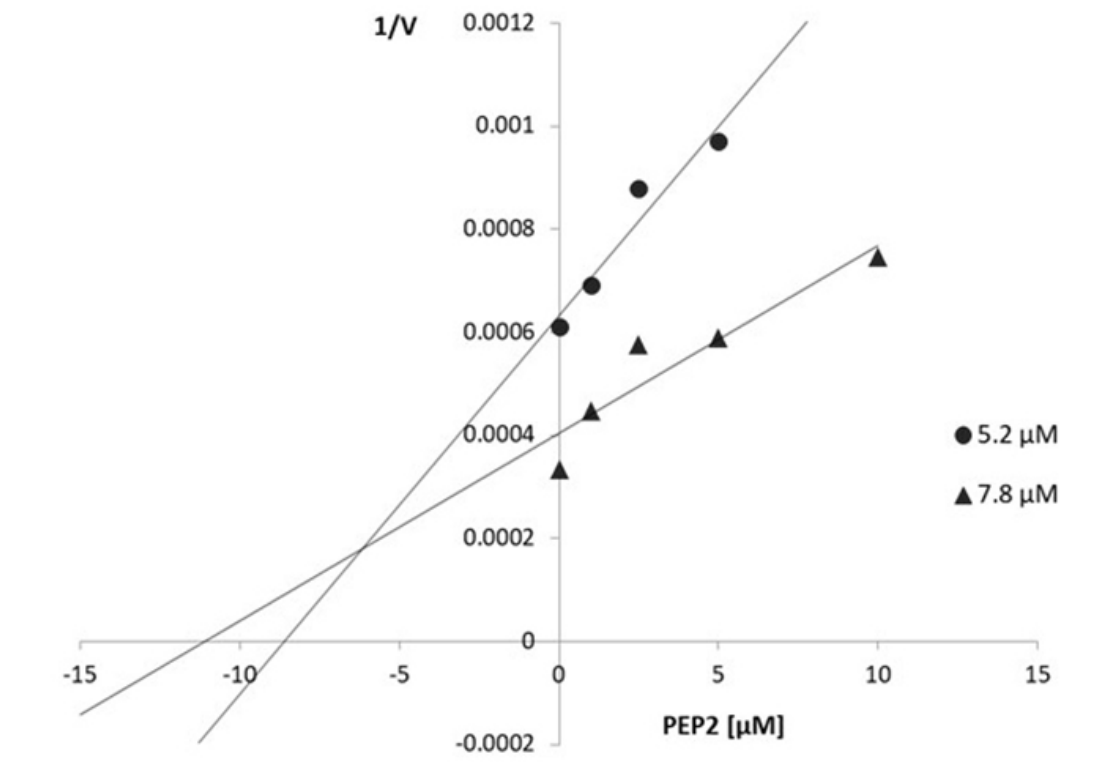
Figure 7. Dixon plot graphic of the inhibition of the cathepsin L activity over the Z-FR-MCA (5.2 and 7.8 µM) by the peptide PEP2 (0; 1.0; 2.5 and 5.0 µM). The intercept in the second quadrant indicates the competitive mechanism of inhibition. The inhibition constant has the value of 1.96